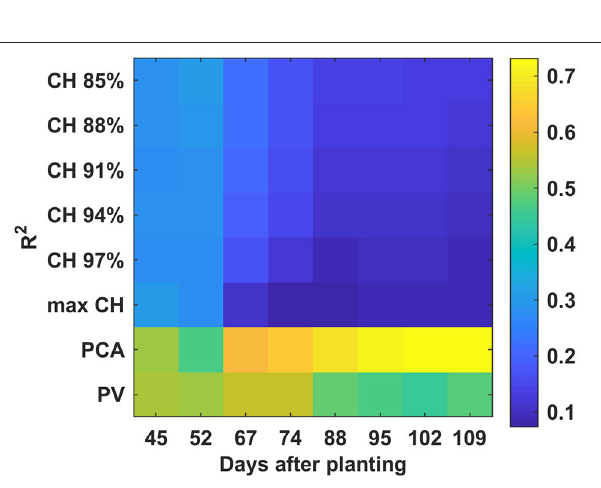
FIGURE 12 | Correlation analysis results between derived parameters and yield with all cultivars combined by days after